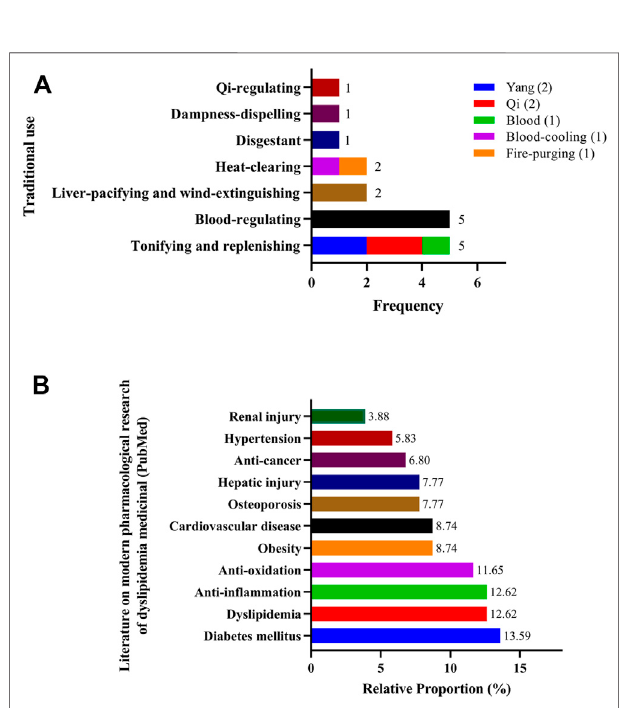
FIGURE5| Purposestatisticsof17commonlyused medicinal materials (A) Traditional use statistics (B) Modern pharmacological research statistics.